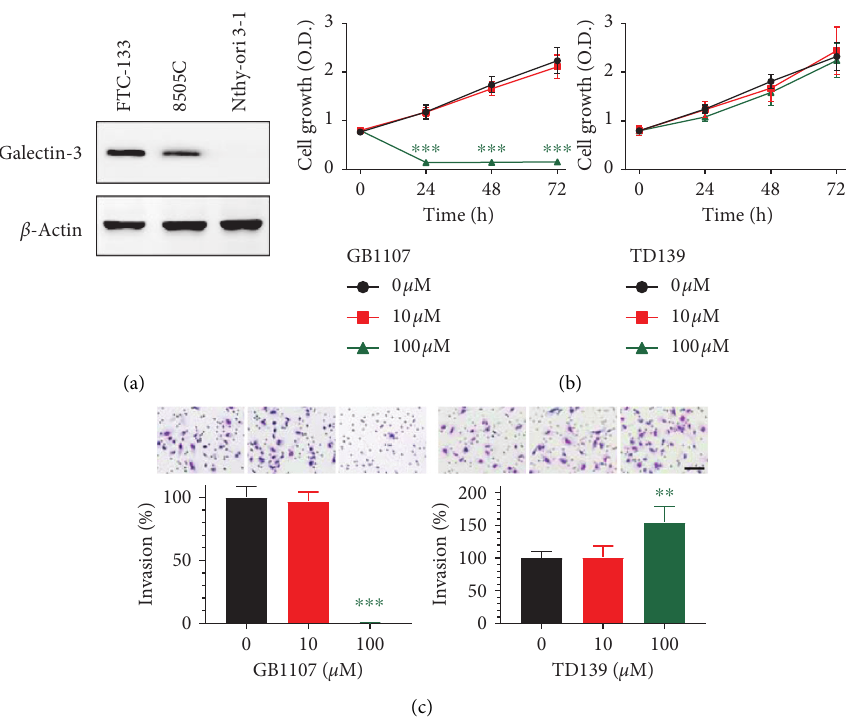
Figure 5: Effects of galectin-3 inhibitors (GB1107 and TD139) on cell growth and invasion in the human thyroid follicular epithelial cell line Nthy-ori 3-1. (a) Protein expression of galectin-3 in thyroid cancer cell lines (FTC-133 and 8505C) and Nthy-ori 3-1. (b) Nthy-ori 3-1 cells were treated with GB1107 or TD139 of the indicated concentrations for 24 to 72h and cell viability was determined using Cell Counting Kit- 8 assay. OD: optical density value at 450nm. (c) Nthy-ori 3-1 cells invading through Matrigel-coated Transwell chambers with or without 24-h GB1107 and TD139 treatment were fixed and quantified. Scale bars, 100 μ m. ∗∗ p < 0 . 01, ∗∗∗ p < 0 .